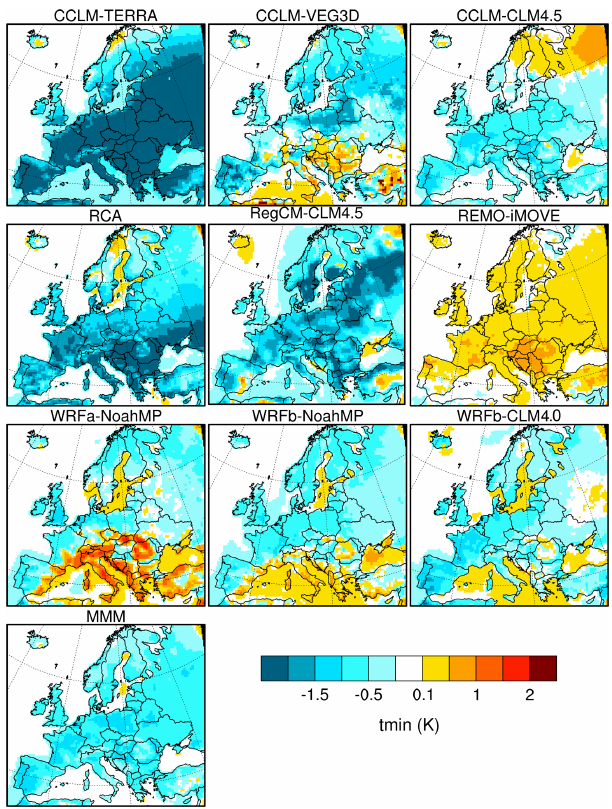
Figure 7. Seasonally averaged net surface shortwave radiation (FOREST minus GRASS) for winter